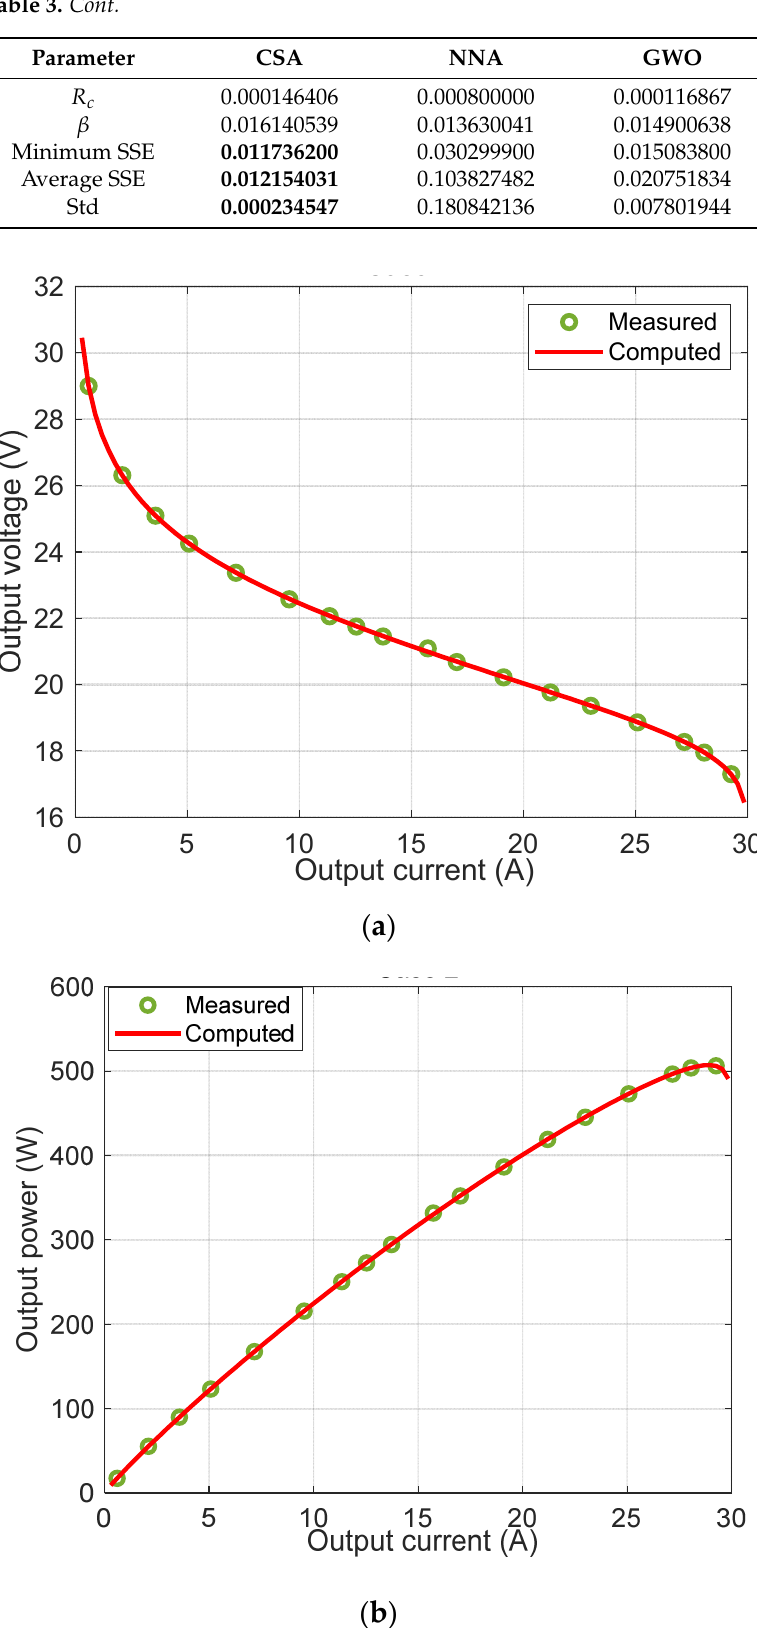
Figure 10. Characteristics of BCS stack: ( a ) current-voltage and ( b ) current-power.